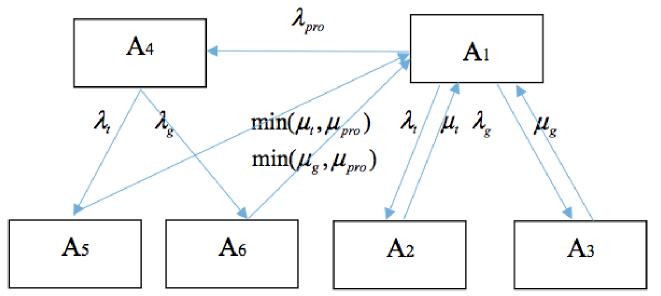
Figure 8. The completed multi-state Markov chain model of generating units incorporating protection function